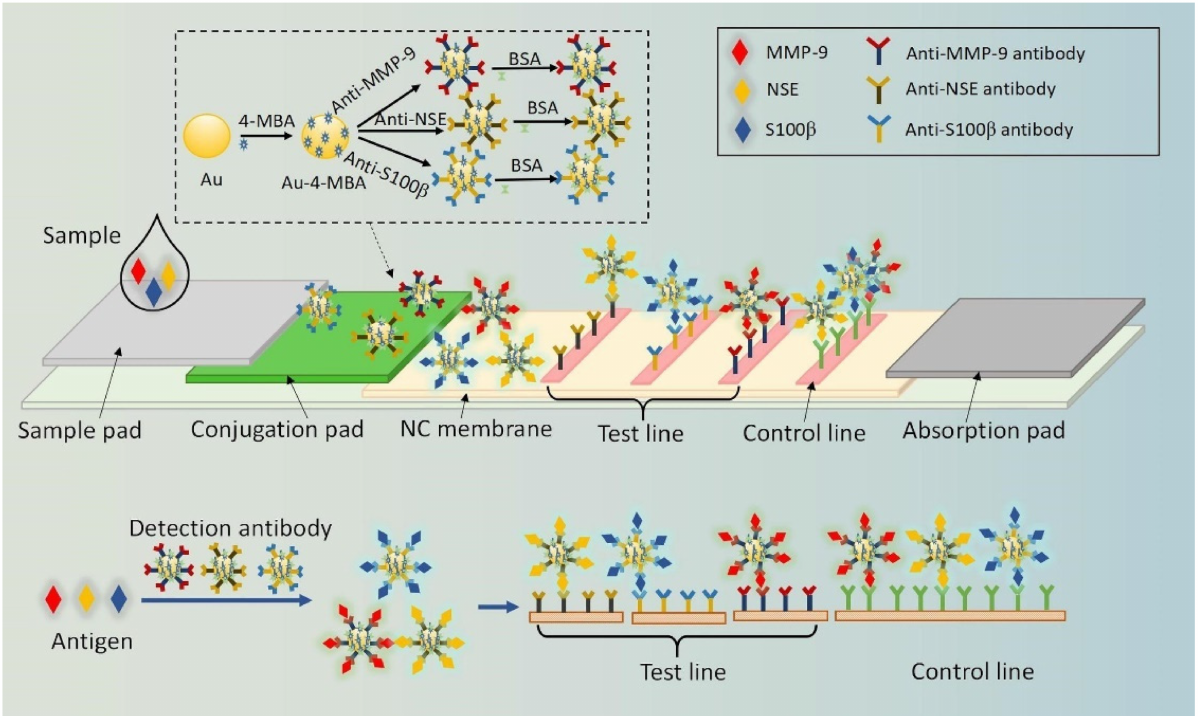
Figure 19. Schematic illustration of the SERS tags-based multiplex lateral flow assay devices. 4-MBA is 4-methoxybenzioic acid; MMP-9 is matrix metalloproteinase-9; NSE is neuro-specific enolase; S100- β is S100 calcium-binding protein B protein; BSA is bovine serum albumin; and NC membrane is nitrocellulose filter membrane. Reproduced with permission from [119]. Copyright 2021 Elsevier B.V.